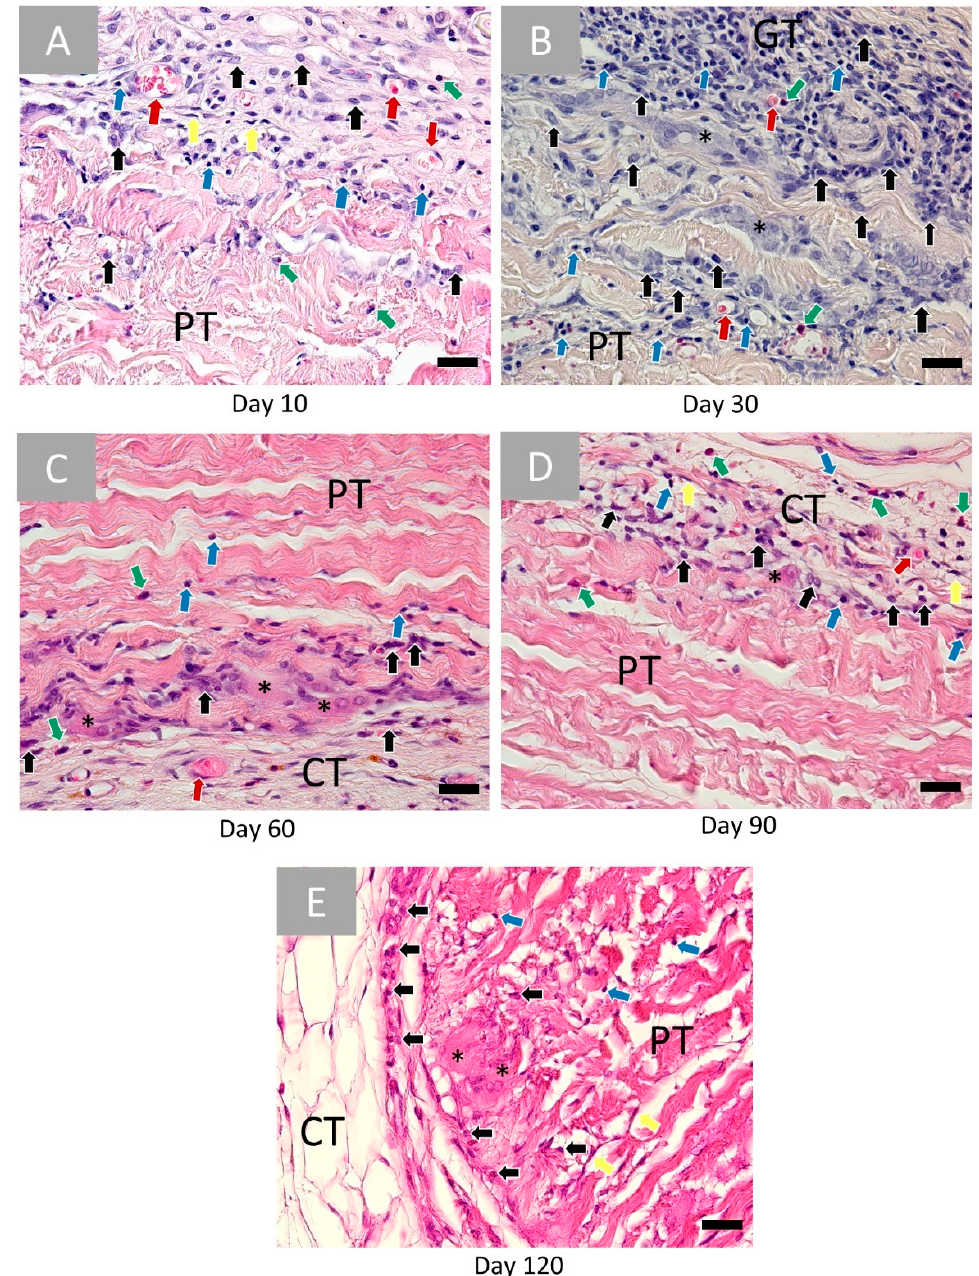
Figure 3. Histopathological images of the bovine pericardium-based vascular patch (PP) at ( A ) 10, ( B ) 30, ( C ) 60, ( D ) 90 and ( E ) 120 days post implantationem within the subcutaneous connective tissue (CT). Red arrows: vessels, black arrows: macrophages, blue arrows: lymphocytes, yellow arrows: fibroblasts, green arrows: eosinophils, and black asterisks: multinucleated giant cells (HE-stainings, 40× magnifications, scale bars = 20 µm).